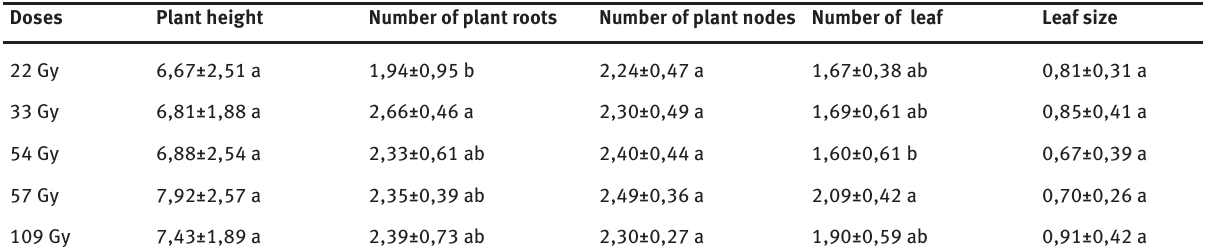
Table 2: Differences between the group averages. Doses Plant height Number of plant roots